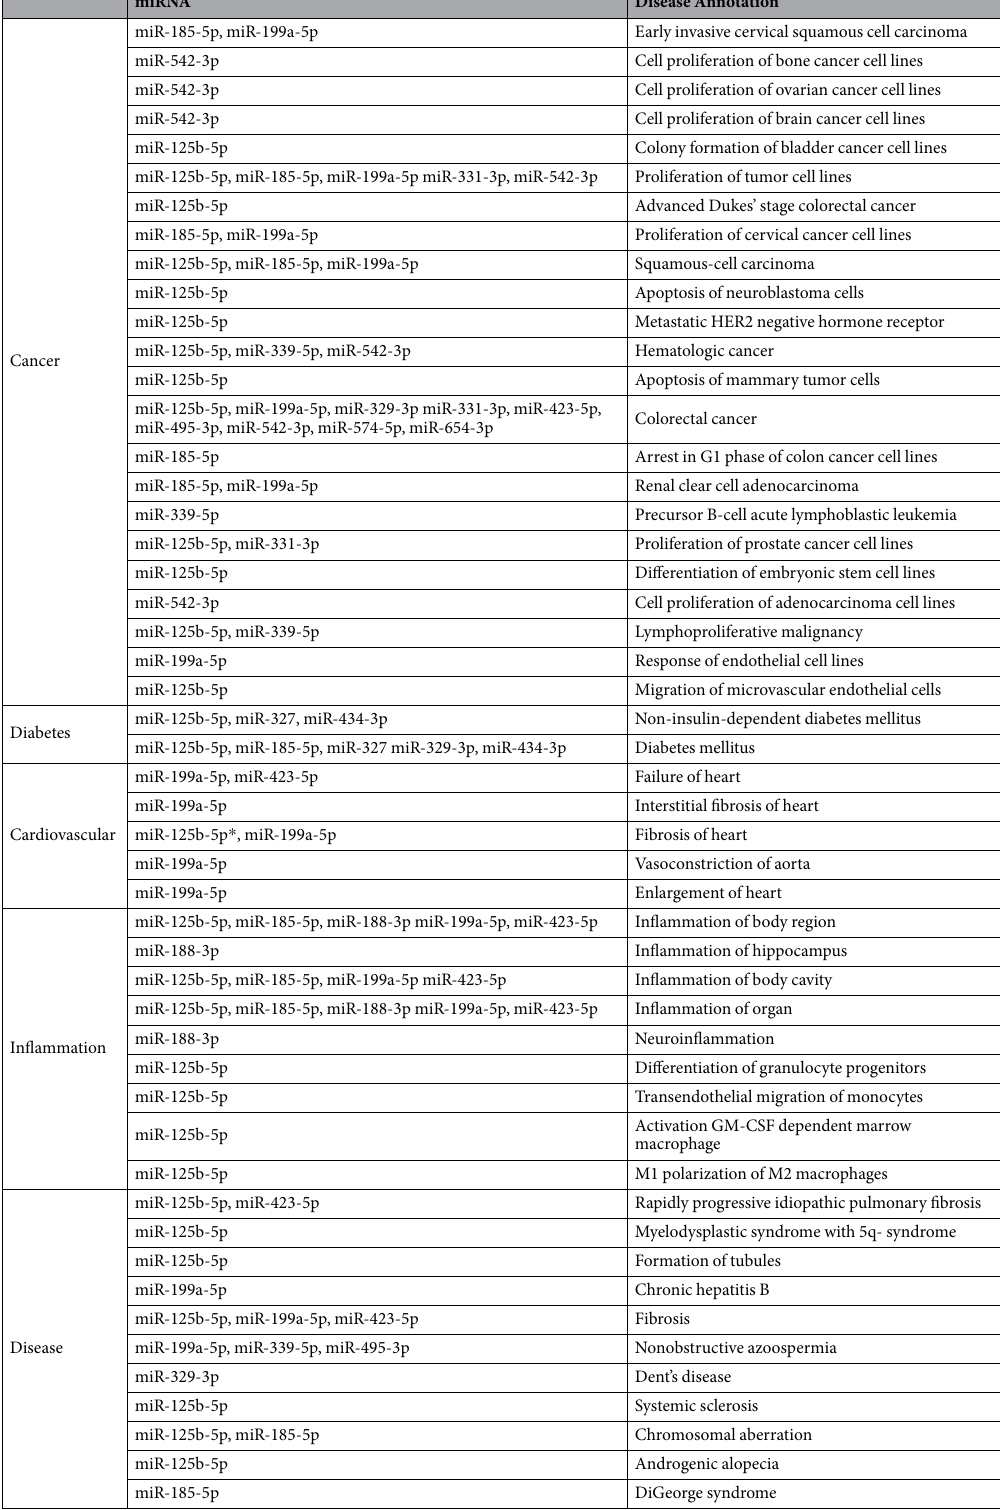
Table 3. Ingenuity pathway analysis (IPA) of miRNA differentially expressed between rd7 and B6. Five major groups with a P value p < 0.05 were identified with the majority of the miRNAs associated with